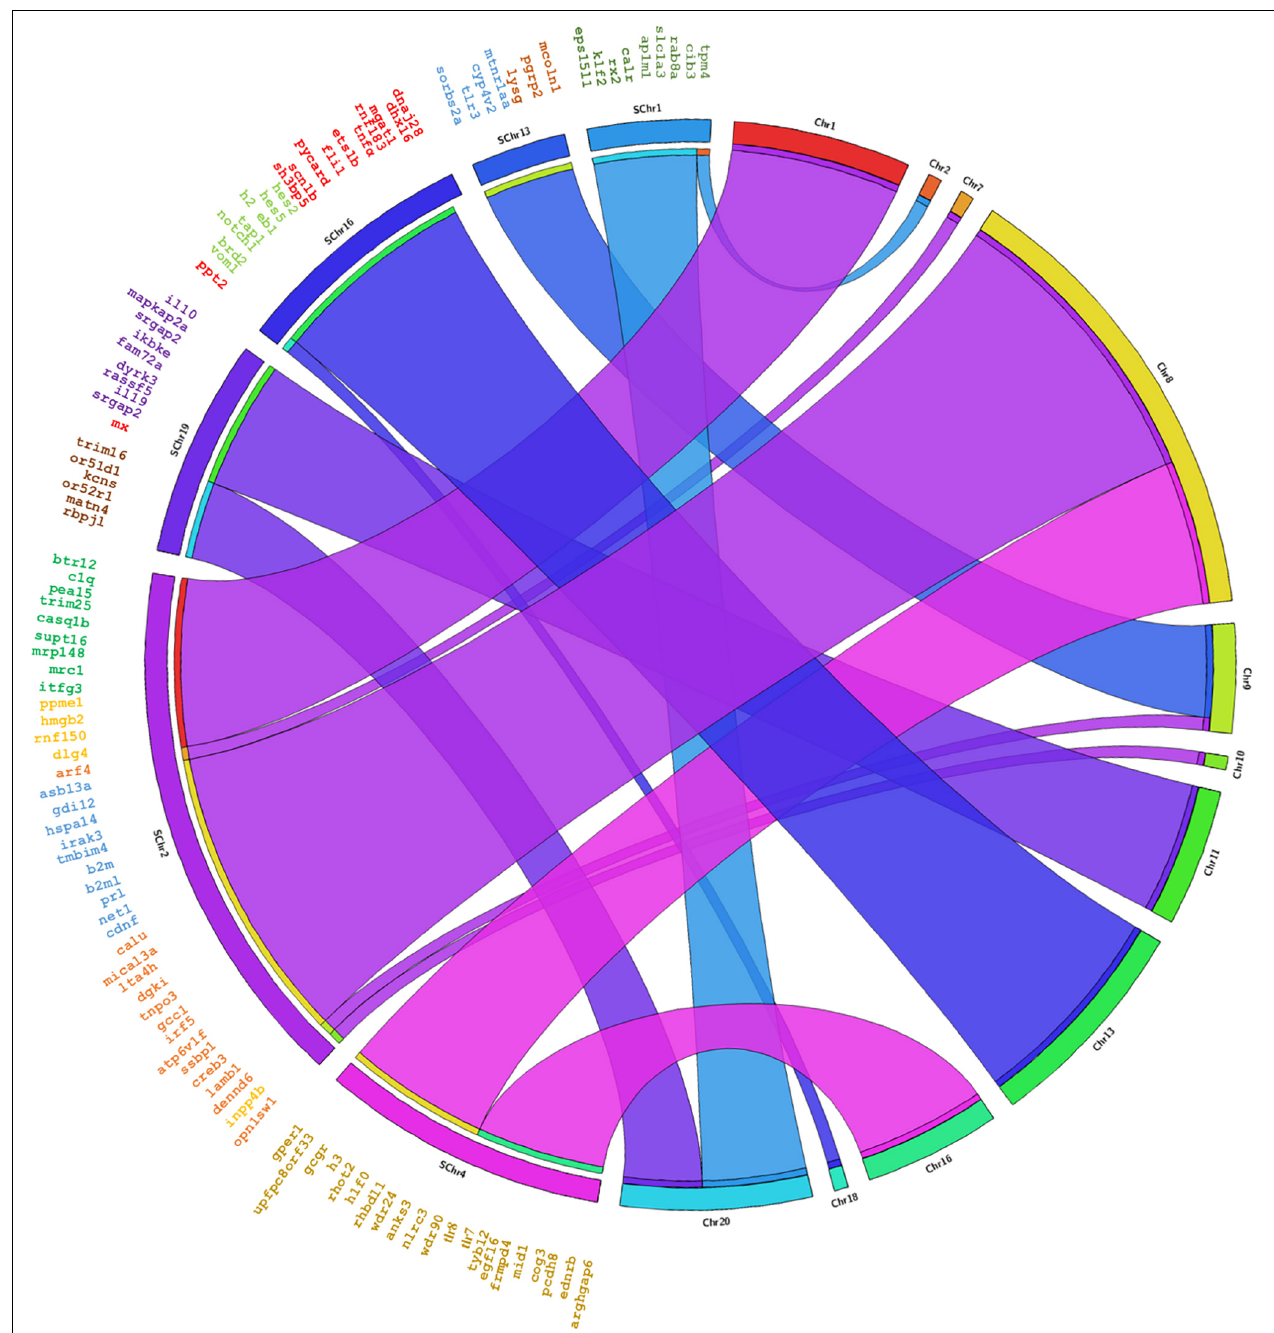
FIGURE 3 | Circos analysis in the species C. semilaevis. On the left side the distribution of the BAC clones of Senegalese sole distributed in chromosomes can be observed. Each BAC clone is represented in a different color. The genes found by annotation are indicated within each BAC clone and their corresponding localization in the C. semilaevis chromosomes is denoted by crossing lines. The BAC clones analyzed are given in Table 1